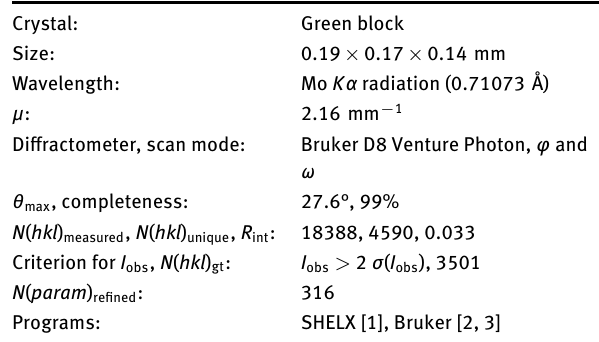
Table 1: Data collection and